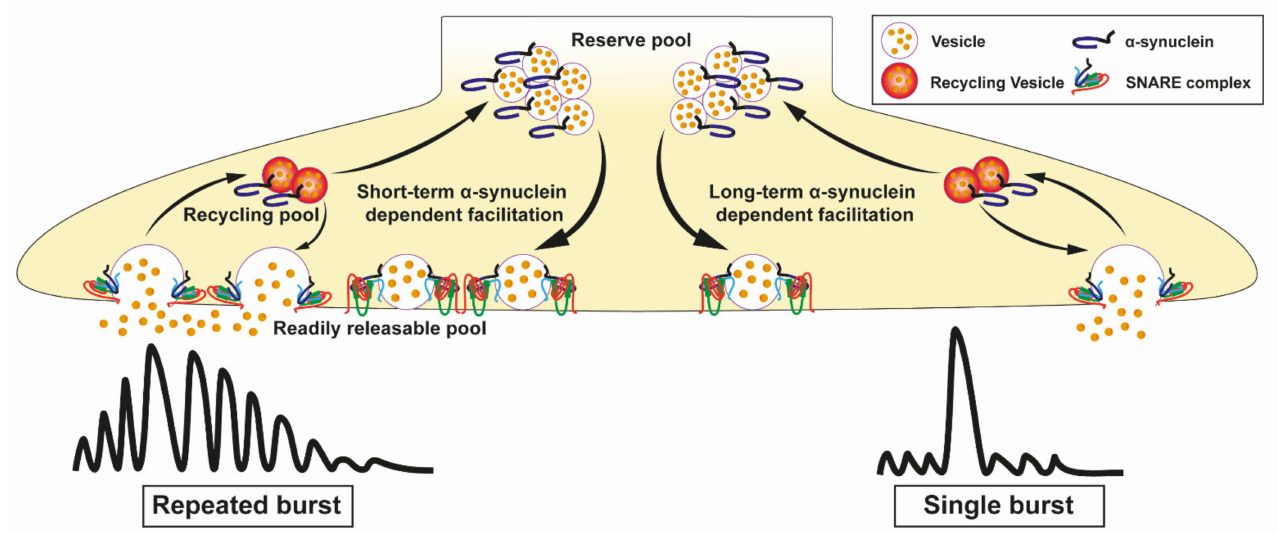
Figure 4. Exocytosis events mediated by α -synuclein ( α -syn) are influenced by action potential bursts. α -syn influences exocytosis in different ways depending on the duration of action potential bursts. It is known that high frequency stimulation is responsible for the exhaustion of dopamine storage pool [158]. Dopamine release is promoted by α -syn when action potential bursts are separated by short intervals or reduces release when the interval between consecutive bursts is in the range of minutes